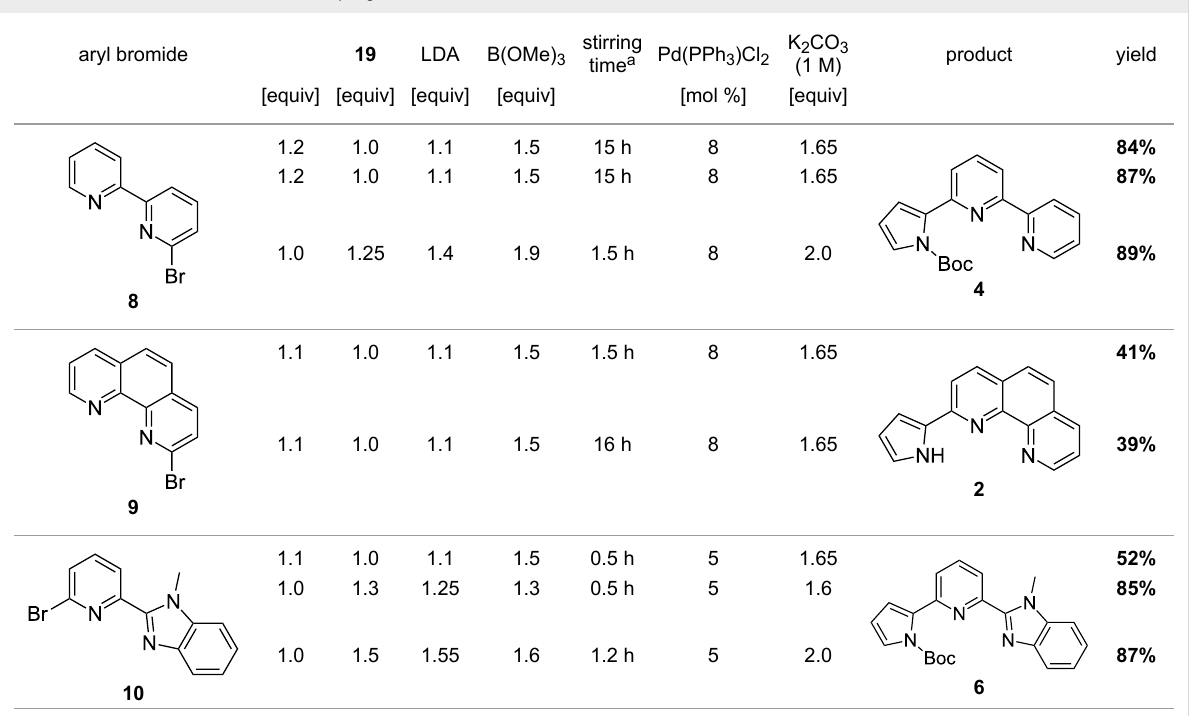
Table 1: Reaction conditions used for coupling